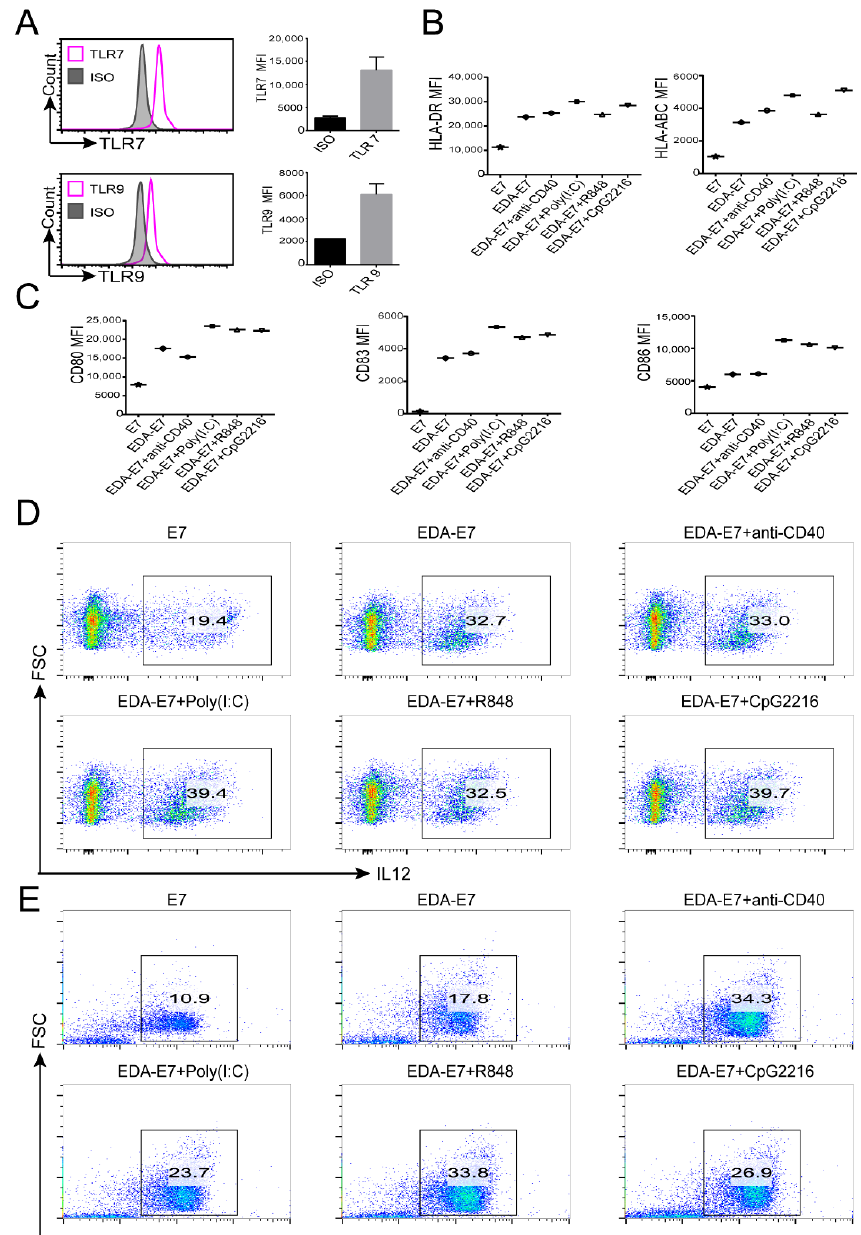
Figure 4. TLR activator upregulated EDA-E7 effect on DCs activation. Flow cytometry analysis for TLR7 and TLR9 expression on monocyte derived DCs (MFI: mean flow index, ISO: isotype control) ( A ); Flow cytometry for DCs antigen presenting molecule expression after stimulation with EDA-E7 and TLR activators ( B ) (n = 2 per group, data was presented as mean); Flow cytometry for DCs costimulatory molecule after stimulation with EDA-E7 and TLR activators ( C ); Flow cytometry for DCs pro-inflammatory cytokines IL-12 ( D ) and TNF α after stimulation ( E ).